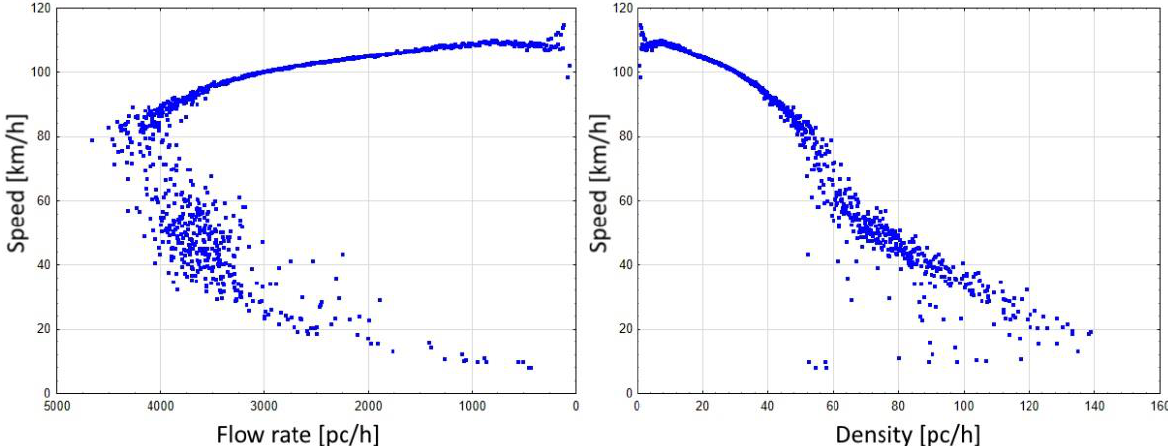
Figure 4. Curves v(q) and v(k) that determine the averaged representation of traffic conditions. Once aggregated, the data may also be used to determine expected ranges of boundary parameters. However, to determine parameters within the maximal flow area (q the data must represent both free-flow and congested traffic. The expected ranges of boundary parameters are determined as follows (Table